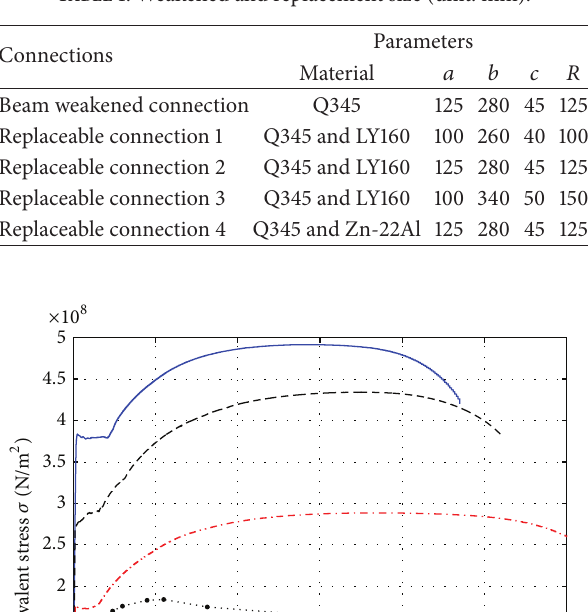
Table 1: Weakened and replacement size (unit: mm).